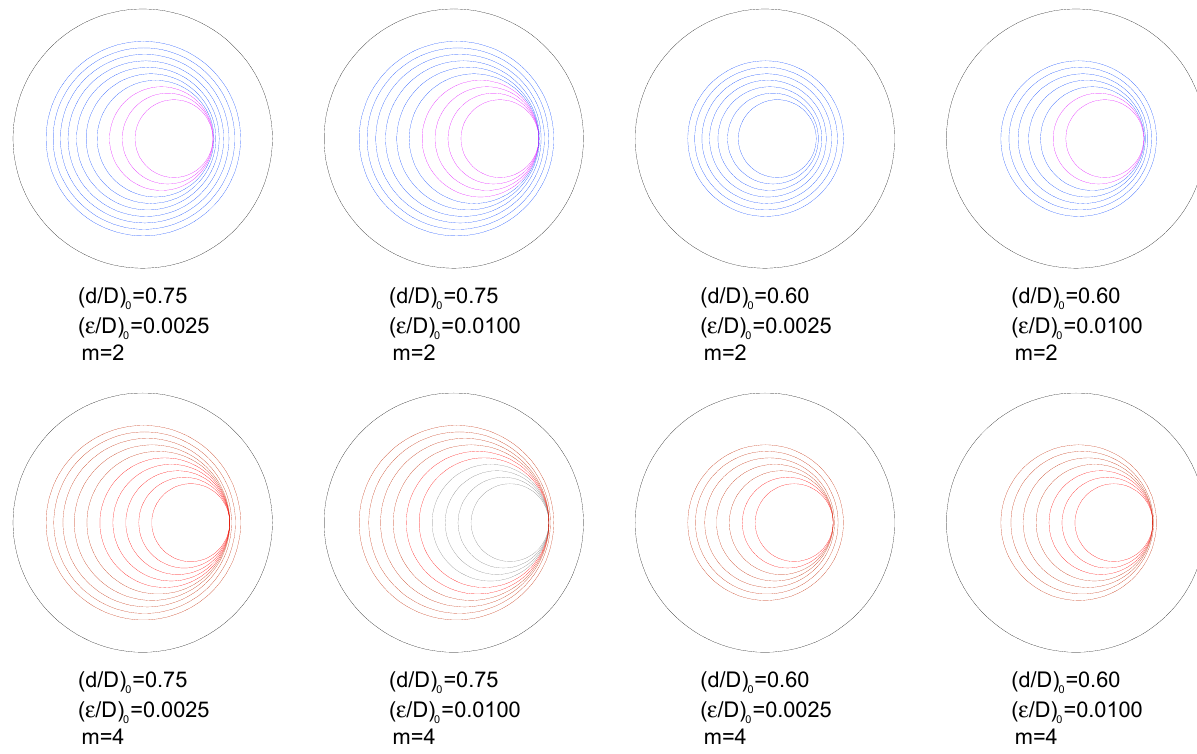
Figure 8. Crack fronts for imposed axial displacement ; m = 2: no contact in blue, partial contact in pink, and full contact in grey; m = 4: no contact in brown, partial contact in red, and full contact in grey.